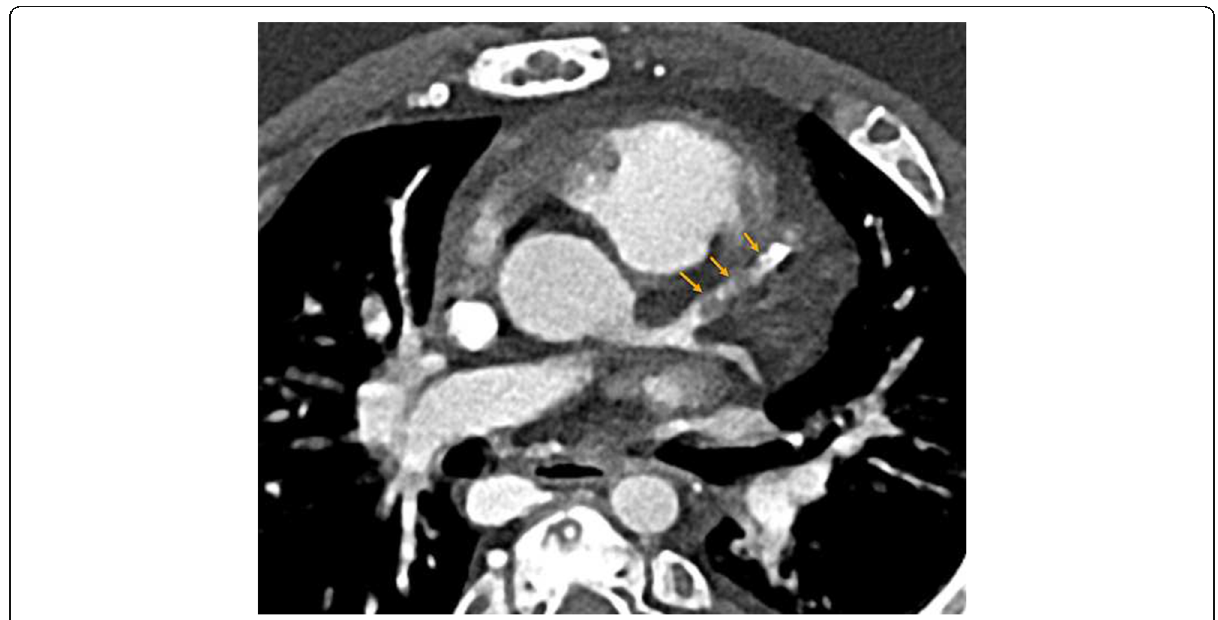
Fig. 3 The coronary CT angiography image obtained on the patient ’ s last admission shows calcific and non-calcific atherosclerotic plaques (arrows) causing subtotal occlusion of the left anterior descending (LAD) coronary